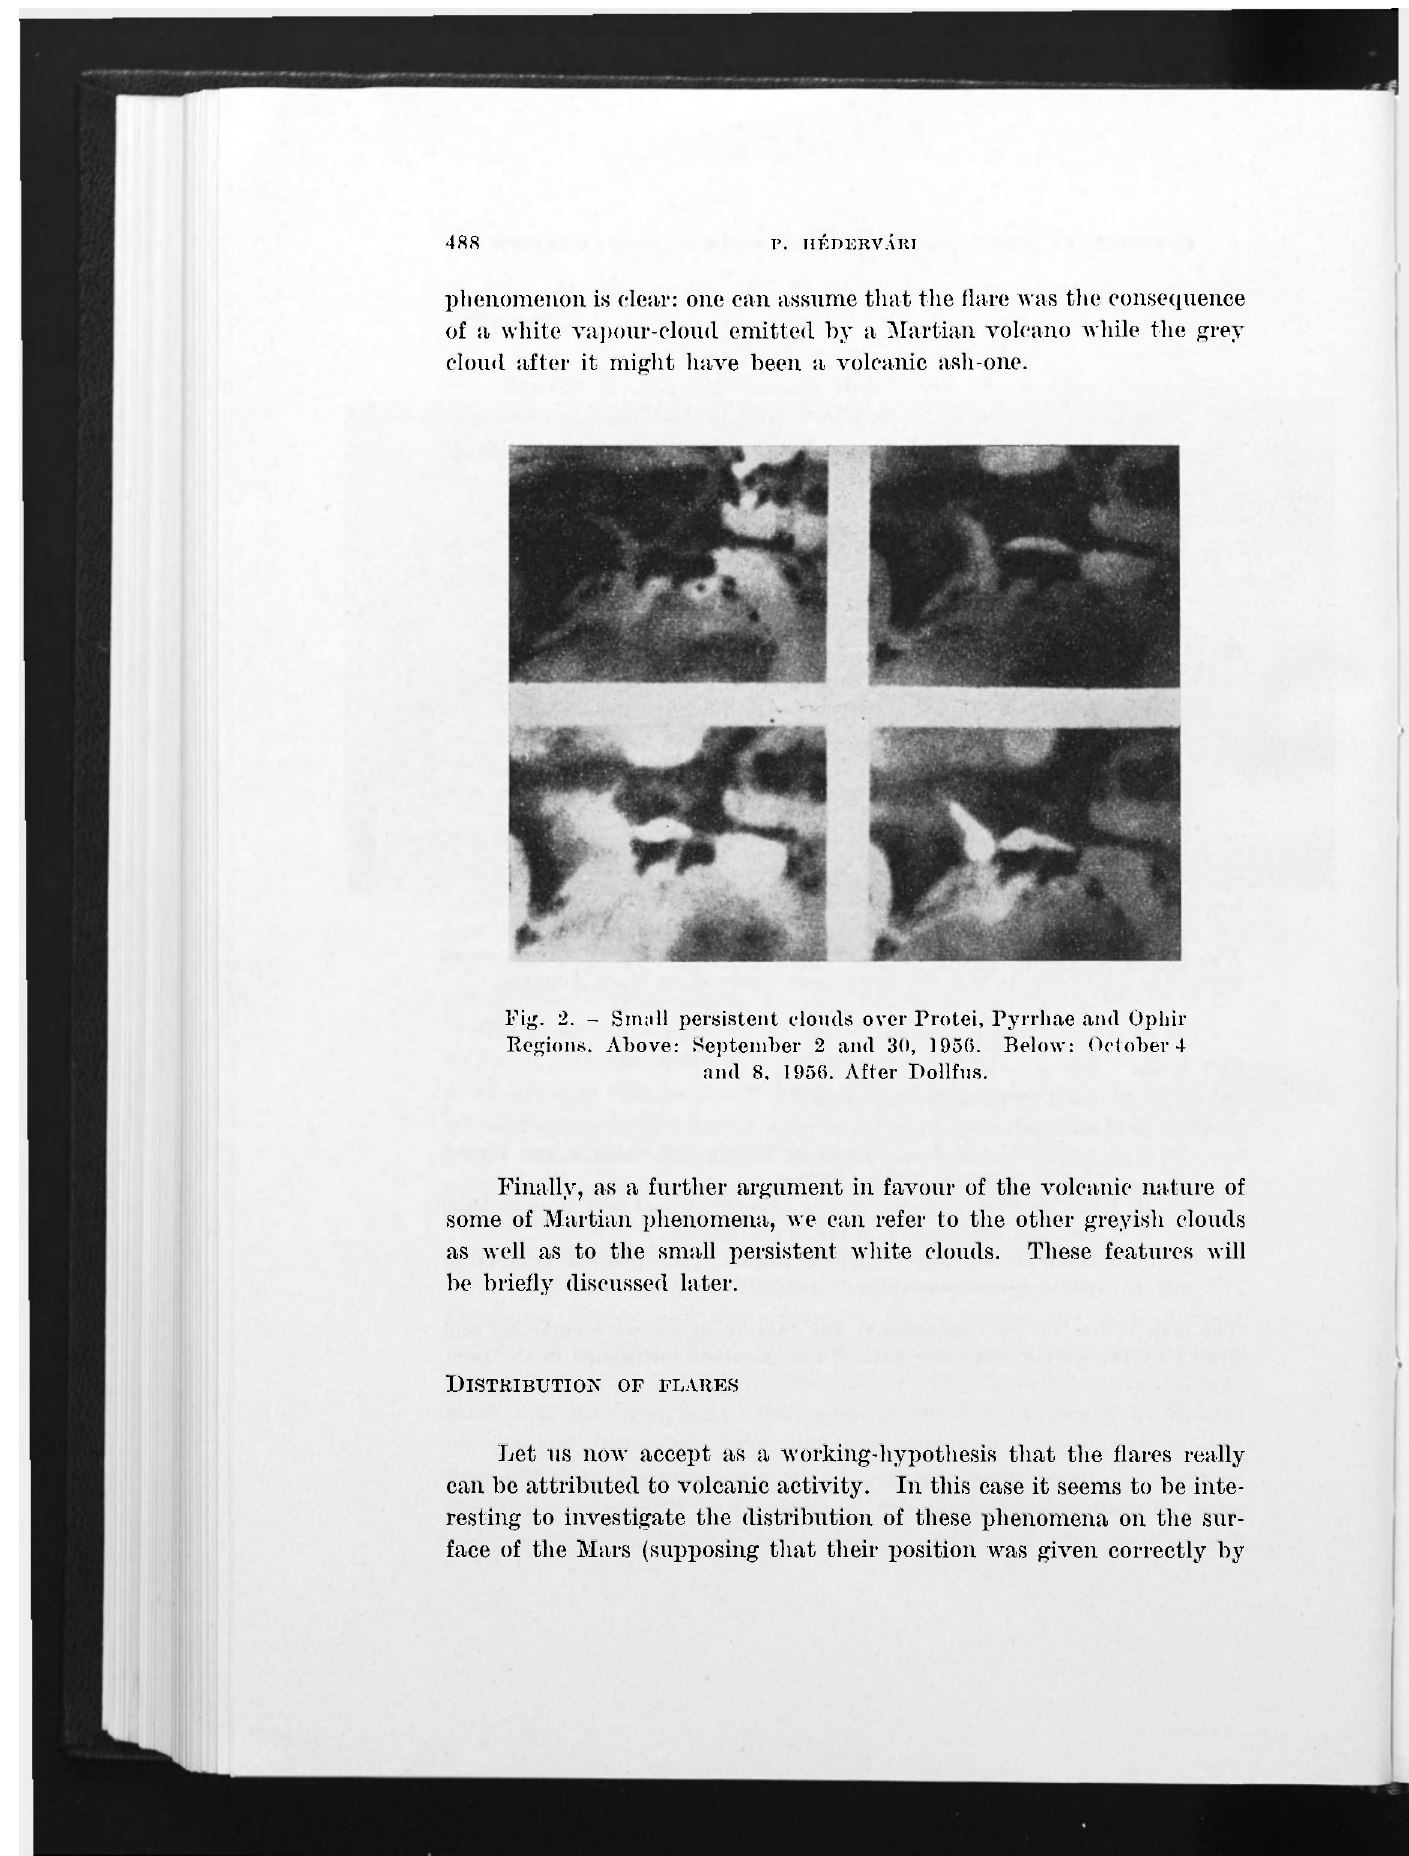
Fig. 2. - Small persistent clouds over Protei, Pyrrhae and Opliir Regions. Above: September 2 and 30,